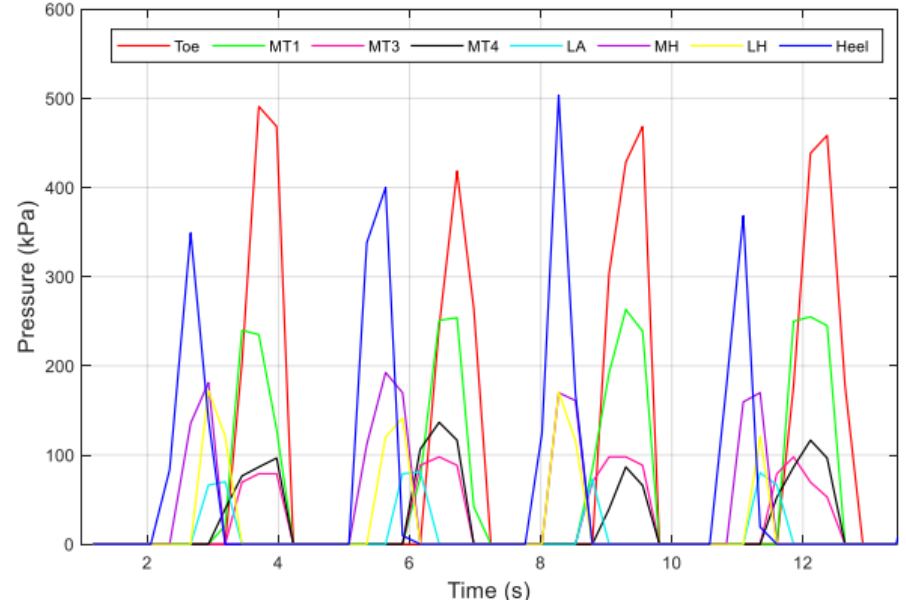
Figure 10. Real-time monitoring of the foot plantar pressure distribution during walking.